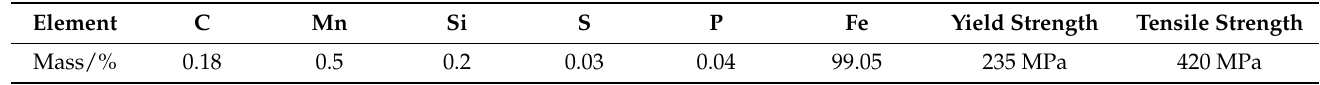
Table 1. Chemical composition, yield strength, and tensile strength of Q235.